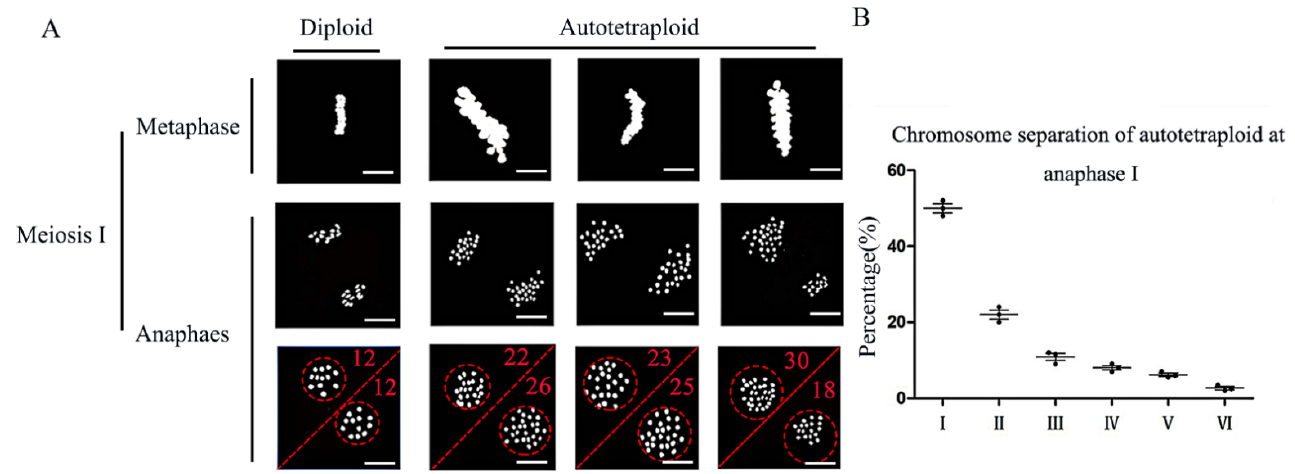
Figure 3. ( A ) Abnormal chromosome segregation behavior of autotetraploid rice at meiosis stage and ( B ) the percentage of the chromosome separation at anaphase I. Bar = 10 μm (I: 24/24; II: 23/25, 22/26, 21/27; III: 20/28, 19/29, 18/30; IV: 17/31, 16/32, 15/33; V: 14/34,13/35,12/36; VI:11/37,10/38).